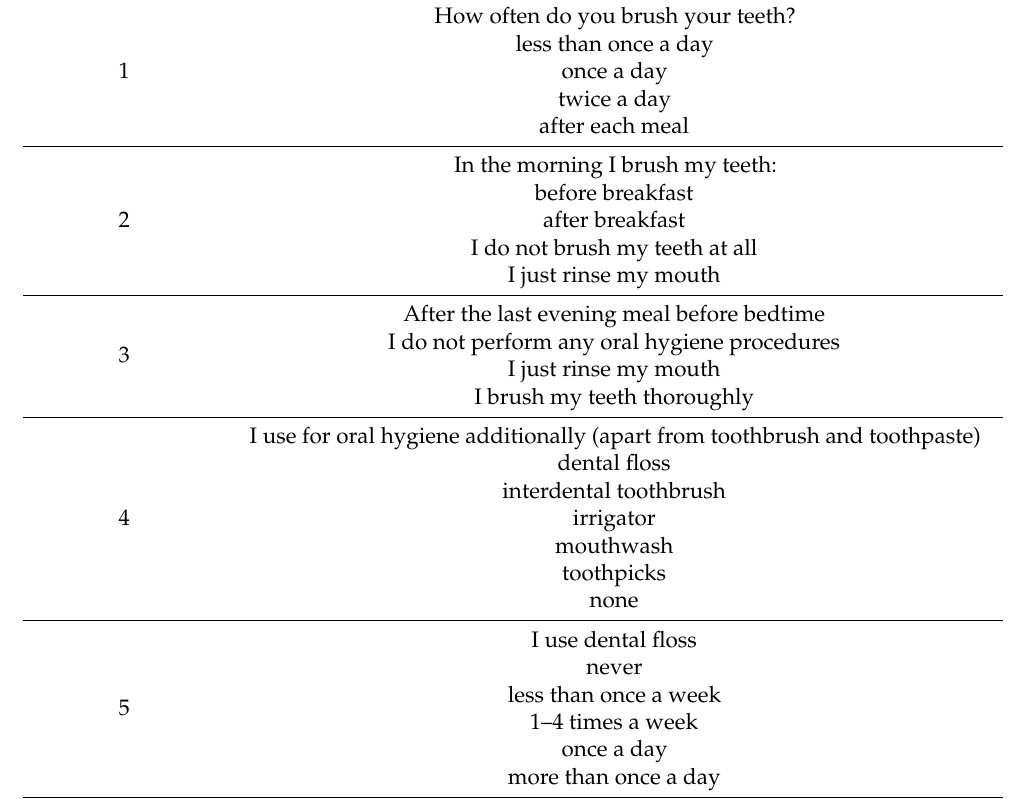
Table 1. The questionnaire